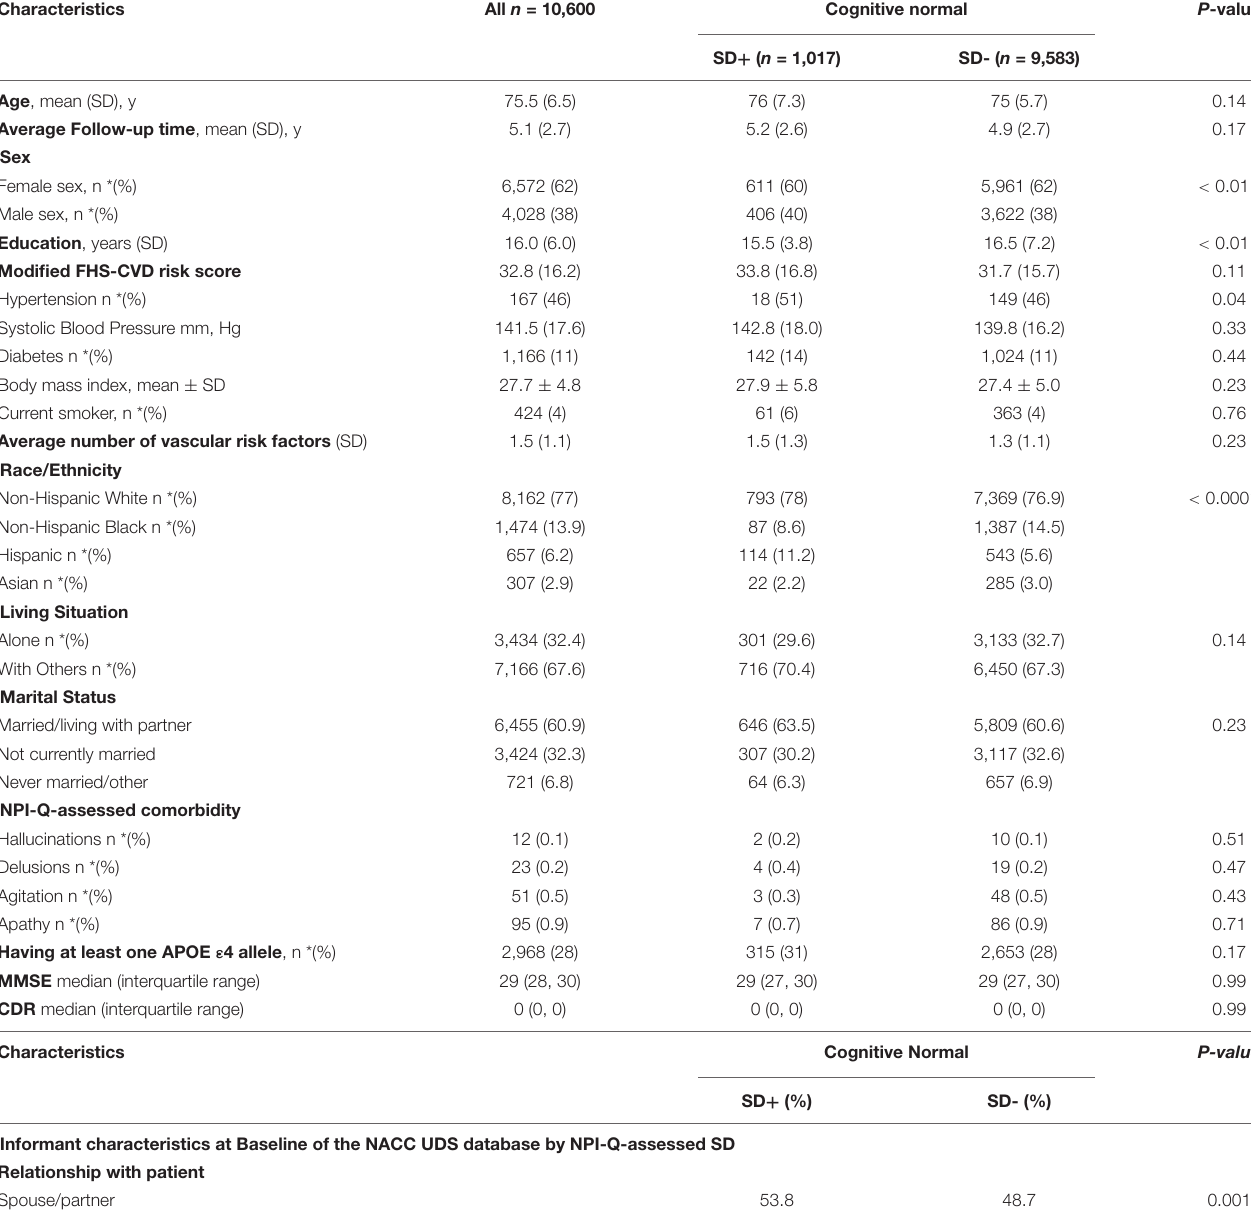
TABLE 1 | Baseline characteristics of cognitive normal study participants by NPI-Q-assessed sleep disturbance (SD), NACC UDS data. Characteristics All n =